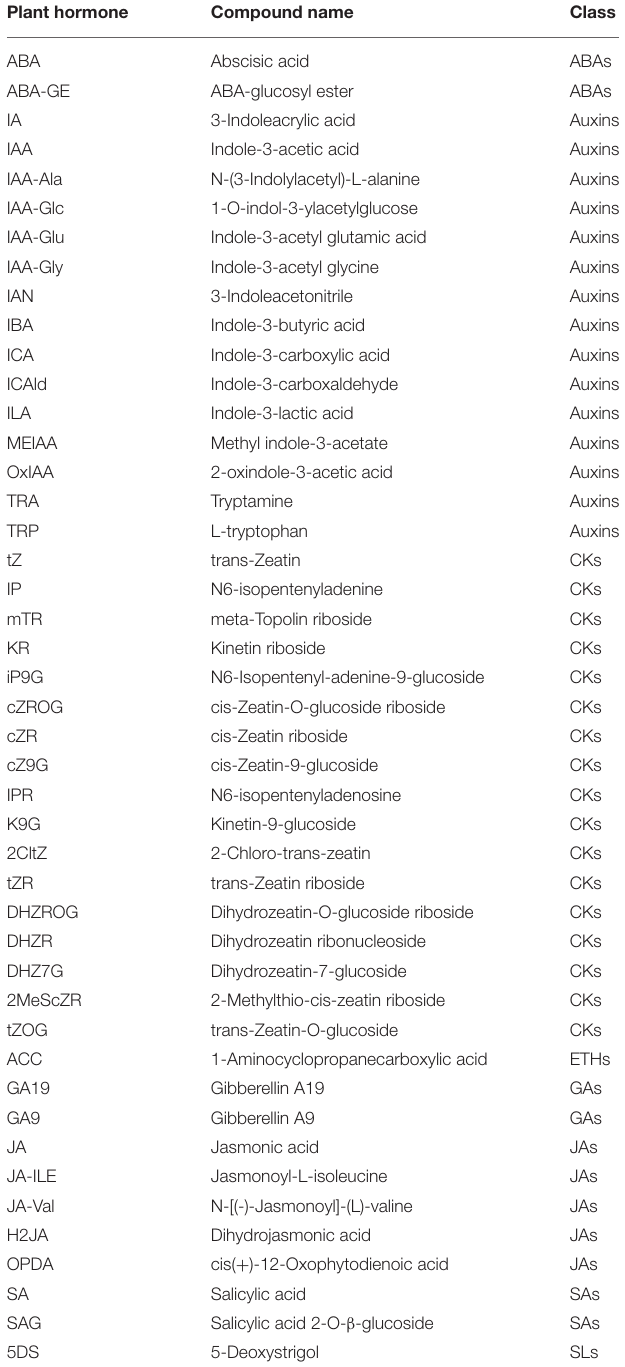
TABLE 1 | Identification of plant hormone components in two varieties of Zanthoxylum bungeanum . Plant